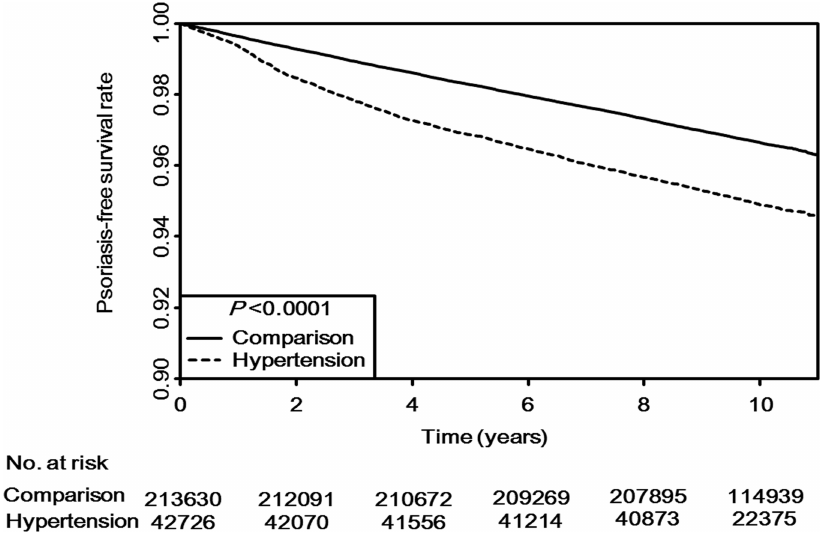
Fig 1. Kaplan–Meier survival curve. The overall psoriasis-free survival analyses for the hypertension and comparison groups are shown. The log-rank P value is significant, indicating a significant difference in psoriasis incidence between the hypertension and comparison